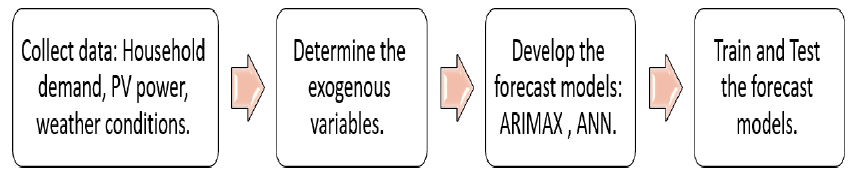
Figure 15. General schematic of the short-term load forecasting procedure implemented in this article.